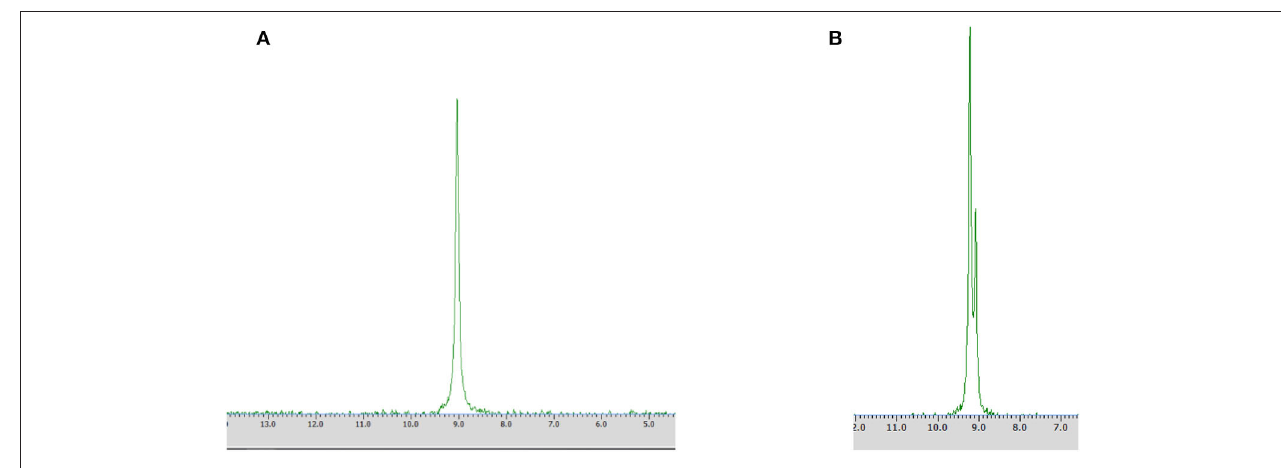
FIGURE 3 | 31 P NMR spectra of biotransformation products recorded with the addition of CSA after the conversion of racemic 1-amino-1-(2-thienyl)methylphosphonic acid with Rhodotorula mucilaginosa (Method A) without (A) and with the addition of racemic mixture of substrate 1 (B) .